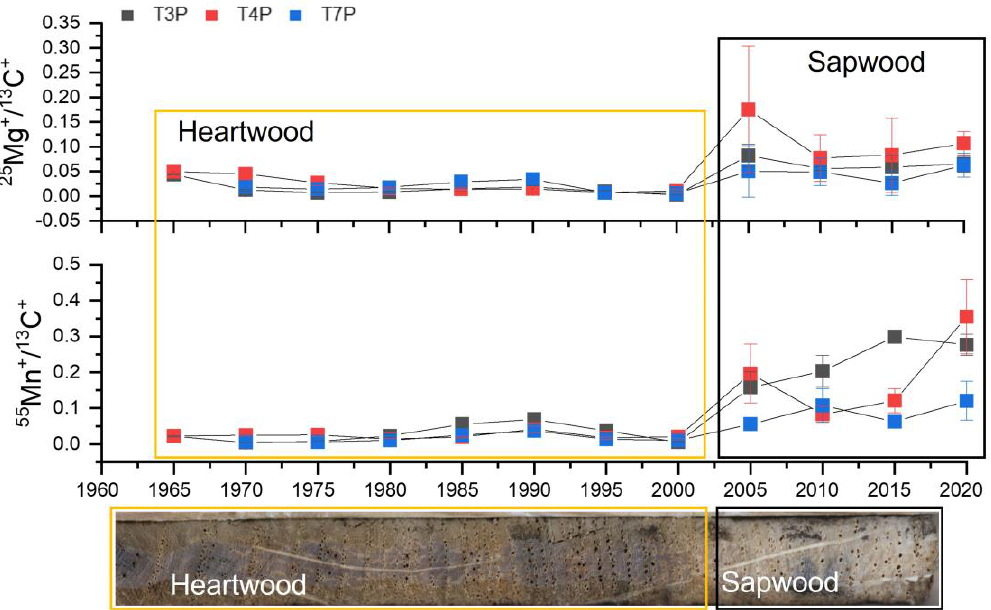
Figure 3. Heartwood-sapwood boundary is related to Mg and Mn signal in three tree cores (T3P, T4P, T7P trees) from Harbin. One tree core of Q. mongolica was taken as representative to visualize the heartwood-sapwood color difference and relate it to the chemical signal of Mg and Mn. Data show the means ± standard deviation (n = 3). Table 2. Spearman’s correlation coefficient to test significant correlations between the elemental signals determined in different tree cores from Harbin (T3P, T4P, T7P trees). Correlation coefficients calculated for the whole tree cores, which are significant at the 95% confidence level ( p < 0.05), are provided in bold and italics. For the p values: “*” p < 0.05, “**” p < 0.01, “***” p < 0.001. Harbin Site